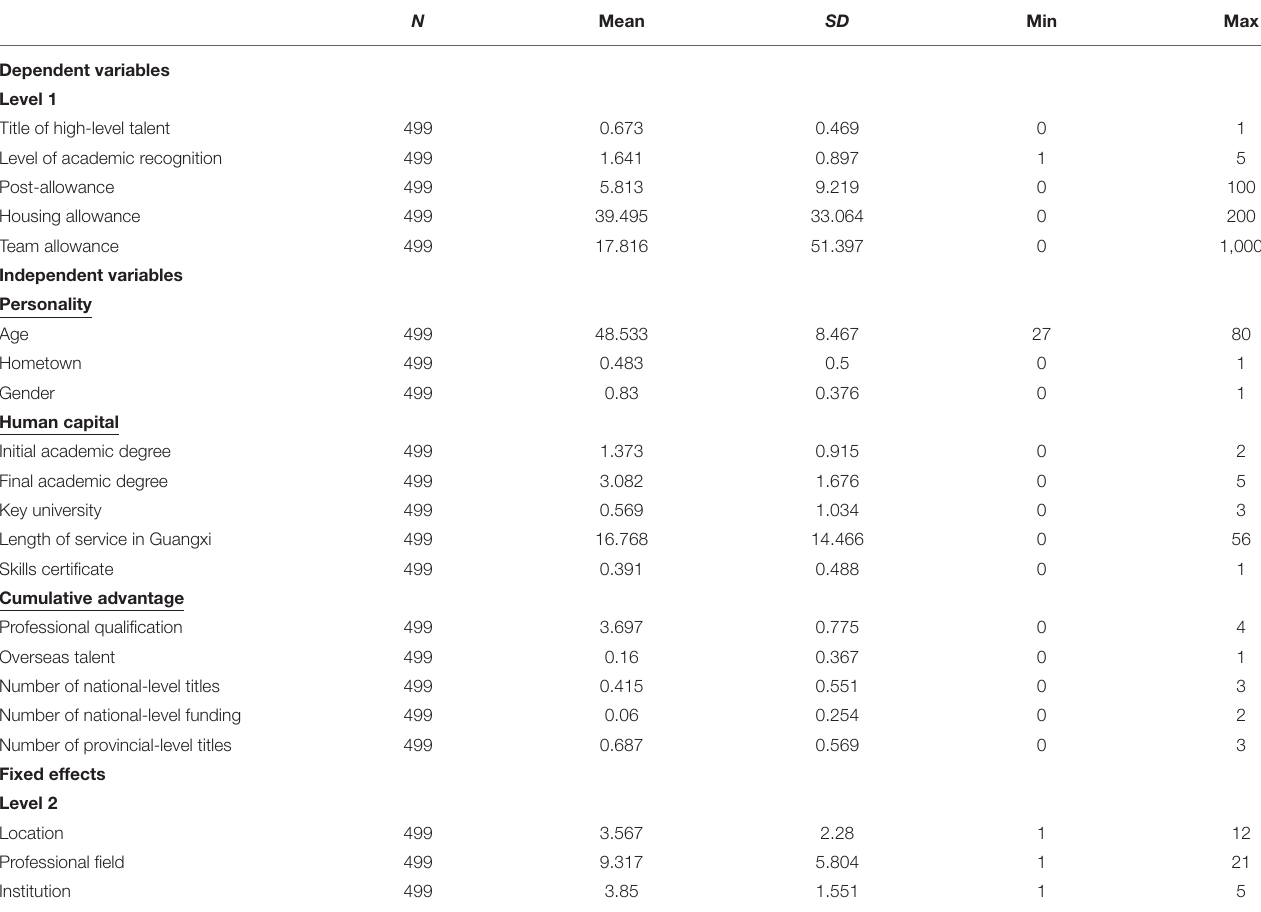
TABLE 2 | Descriptive statistics of related